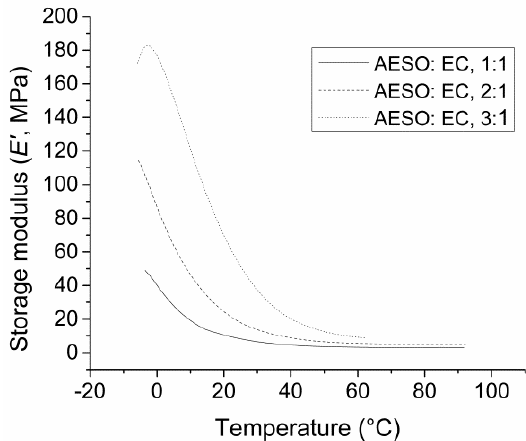
Figure 6. Storage modulus as a function of temperature for AESO-EC thermosets.